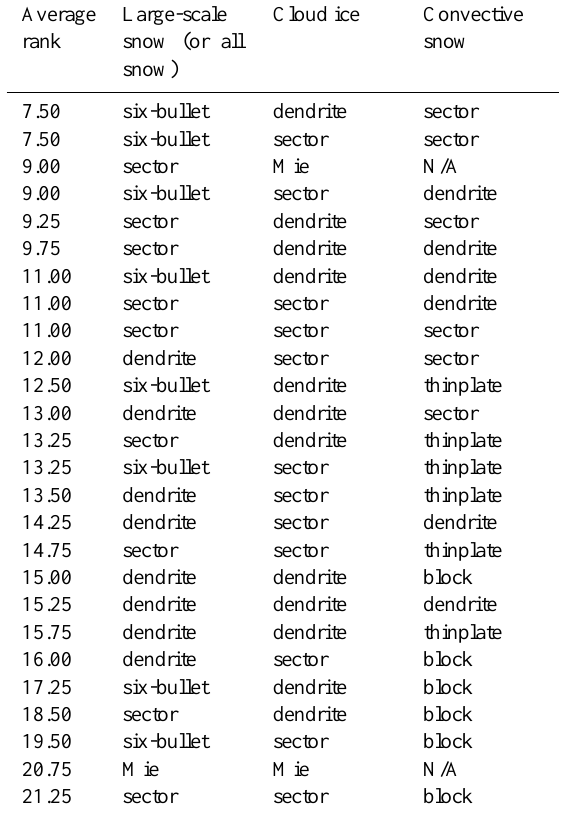
Table 4. Fine-search combinations ranked according to their aver- age position in the statistics of fit.